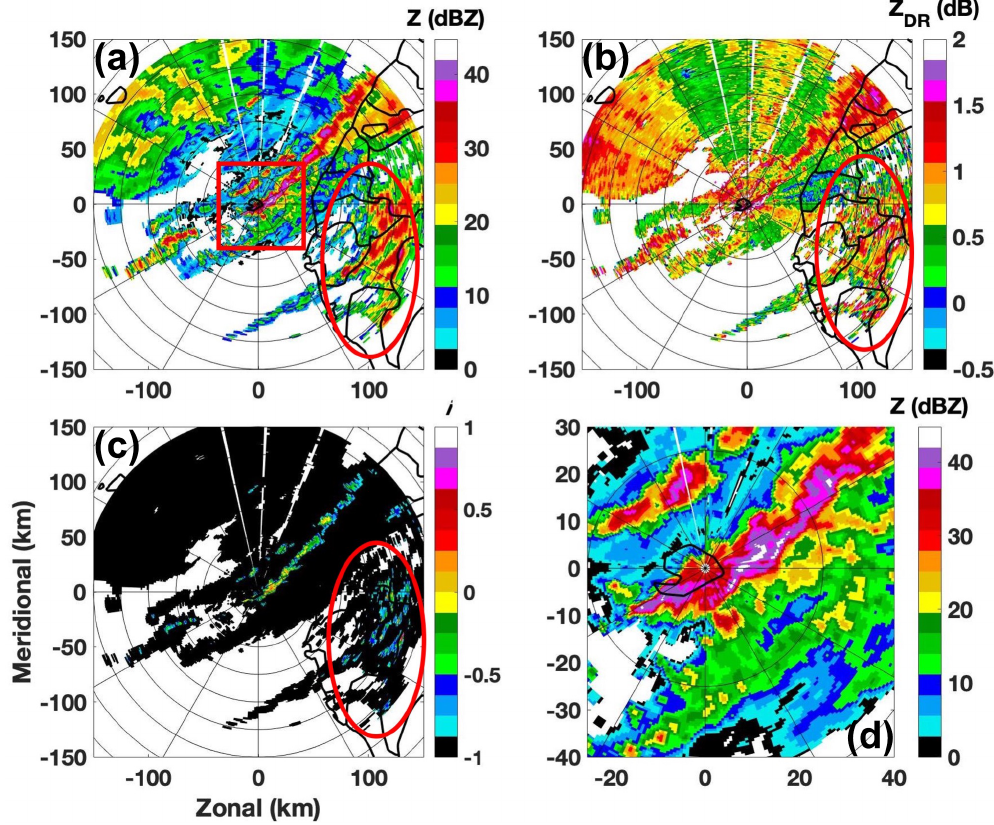
Figure 10. Radar variables of reflectivity (a) , differential reflectivity (b) , separation index (c) , and (d) reflectivity within the red rectangular in (a) . The radar data were collected by RCMK at 04:02UTC, 9 August